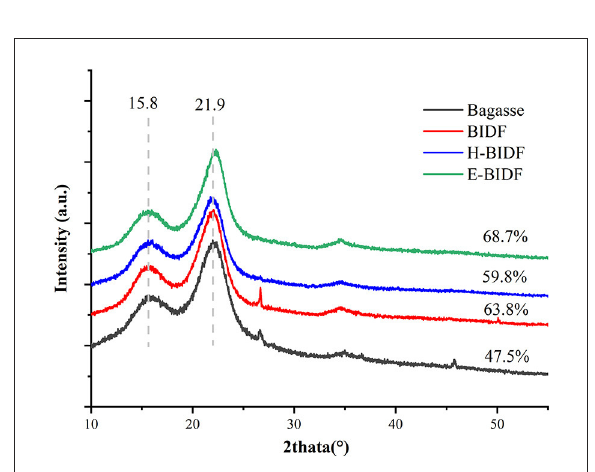
FIGURE5 The XRD patterns of bagasse, BIDF, H-BIDF and E-BIDF.